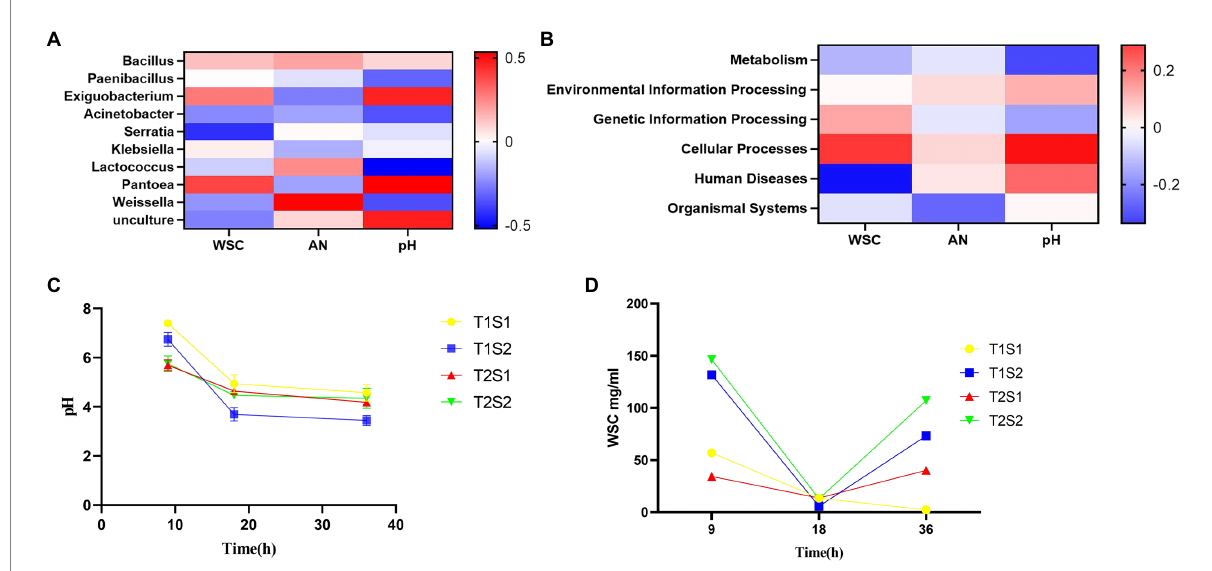
FIGURE 3 Spearman correlation between WSC, pH and AN in the fermentation broth and the relative abundance of the top 10 bacterial genera (A) and functional predictions of bacteria (B) ; trends in pH (C) ; and WSC content (D) of the fermentation broth with increasing incubation